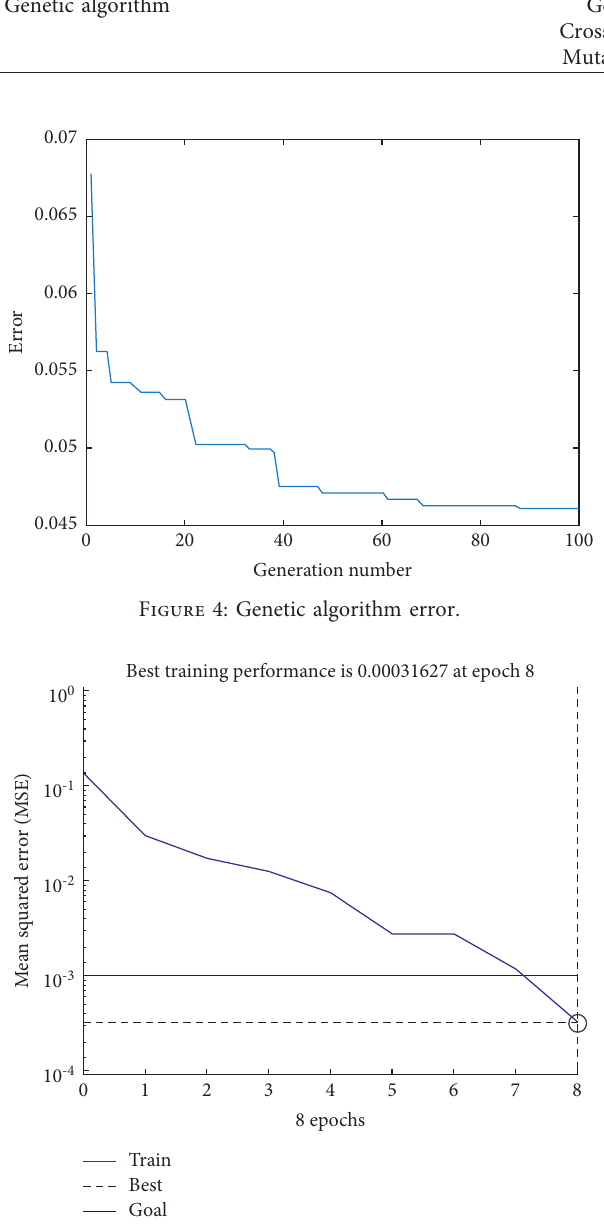
Figure 5: BP neural network error.